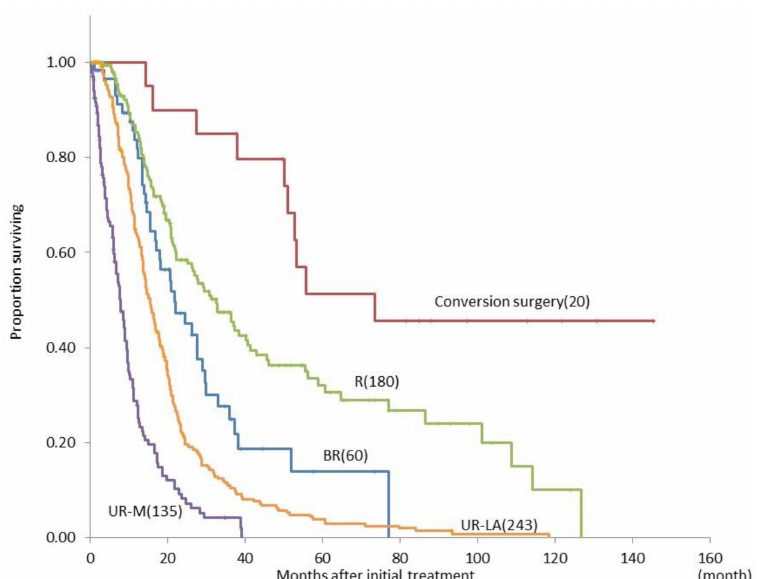
Figure 4. Comparison of the overall survival curves between patients with pancreatic ductal adeno- carcinoma judged as R ( n = 180), BR ( n = 60), UR-LA ( n = 243), or UR-M, ( n = 135) according to the NCCN guideline, who underwent conversion surgery ( n = 20). Abbreviations: R, resectable cancer; BR, borderline resectable cancer; UR-LA, unresectable locally advanced cancer; UR-M, unresectable cancer with metastasis; NCCN, National Comprehensive Cancer